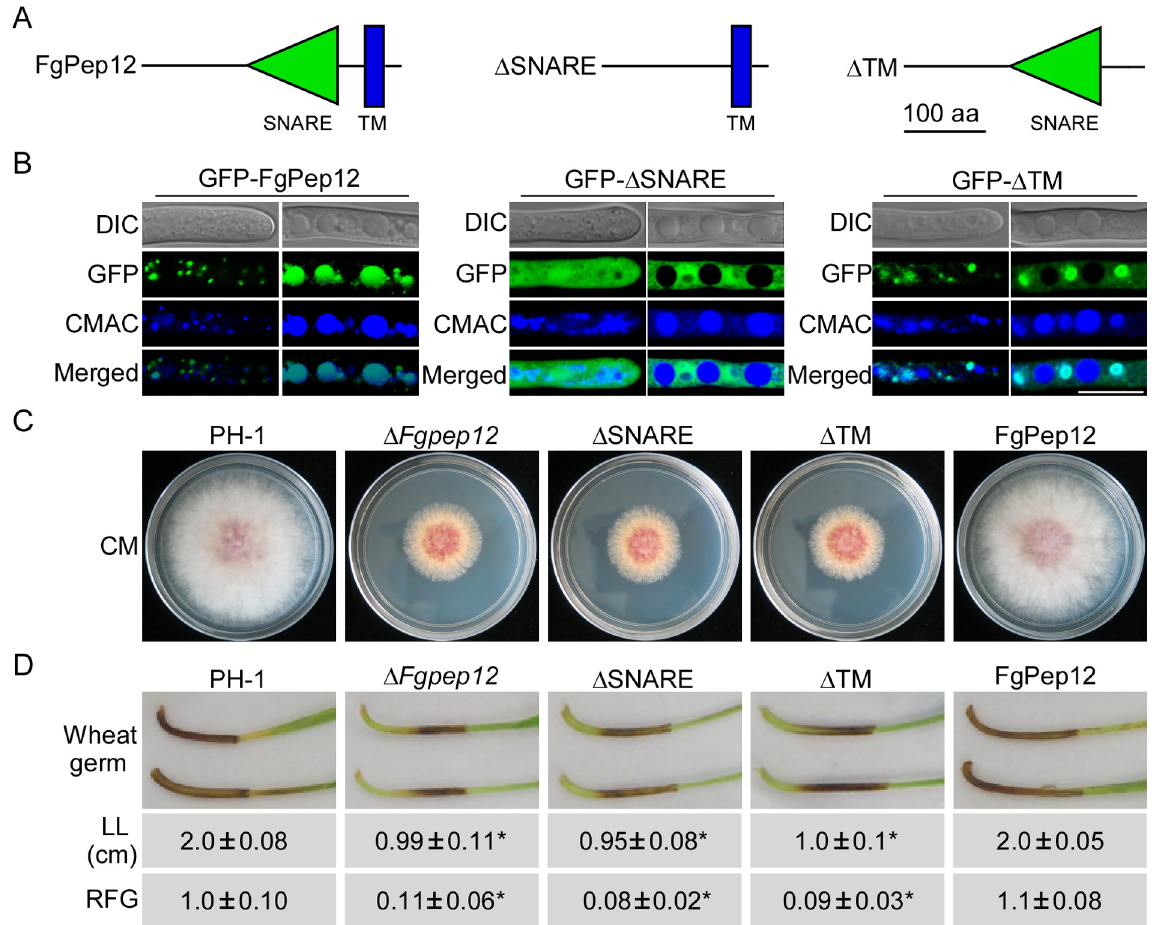
Fig 4. The TM and SNARE domains of FgPep12 are required for its cellular localization and biological function. (A) Diagram of FgPep12 and domain deletion strategy. (B) Subcellular localization of domain deletion proteins. Bar = 10 μ m. (C) Vegetative growth and colony morphology of the domain deletion transformants. (D) Infection assay of the domain deletion transformants. Wheat germs were drop- inoculated with conidial suspensions of the indicated strains. Lesion length (LL) was measured at 10 dpi and photographed. Relative fungal growth (RFG) was analyzed by quantification of F . graminearum 28s rDNA relative to wheat genomic TaACTIN DNA. ± SD was calculated from three independent experiments, and asterisks indicate statistically significant differences ( p <